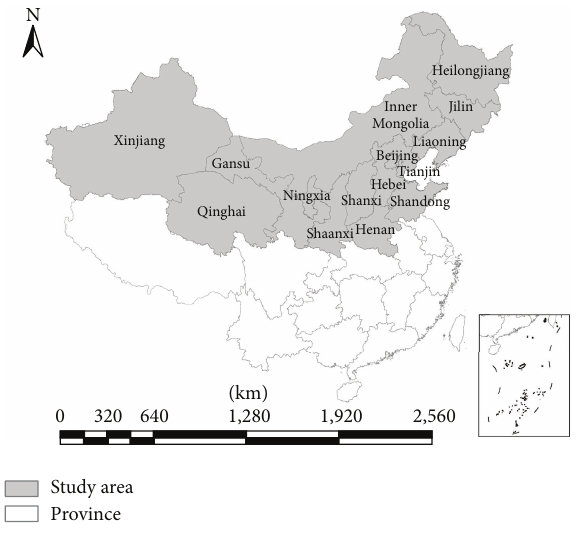
Figure 1: Location of study